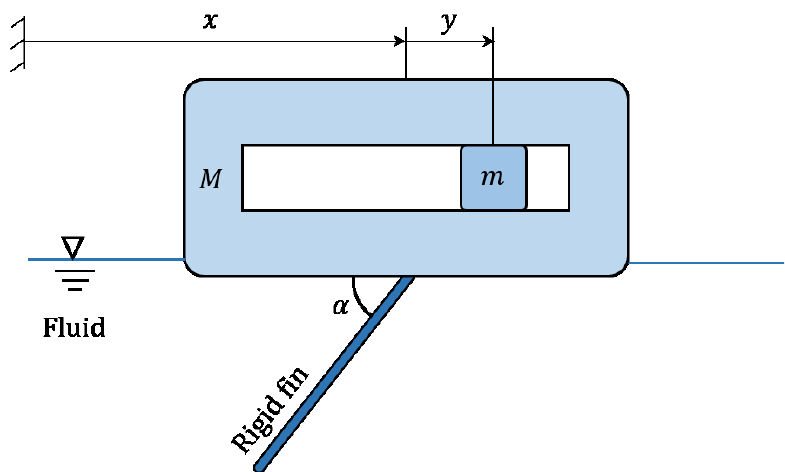
Figure 1. Schematic of the vibratory swimmer consisting of a main body, an oscillating mass m , and a rigid fin attached to the bottom surface of the swimmer at an orientation α